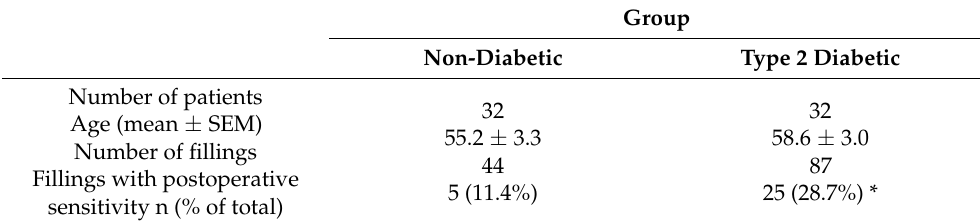
Incidence of postoperative sensitivity after placement of composite restoration in type 2 diabetic and non-diabetic patients.